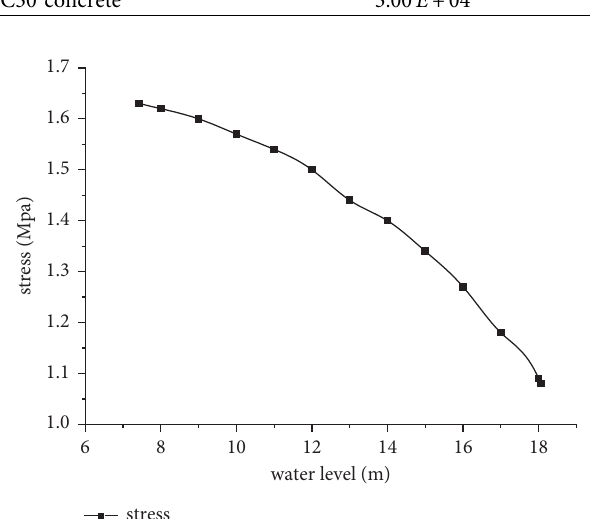
Figure 5: Stress curve of pier at the most disadvantage position under ship collision.